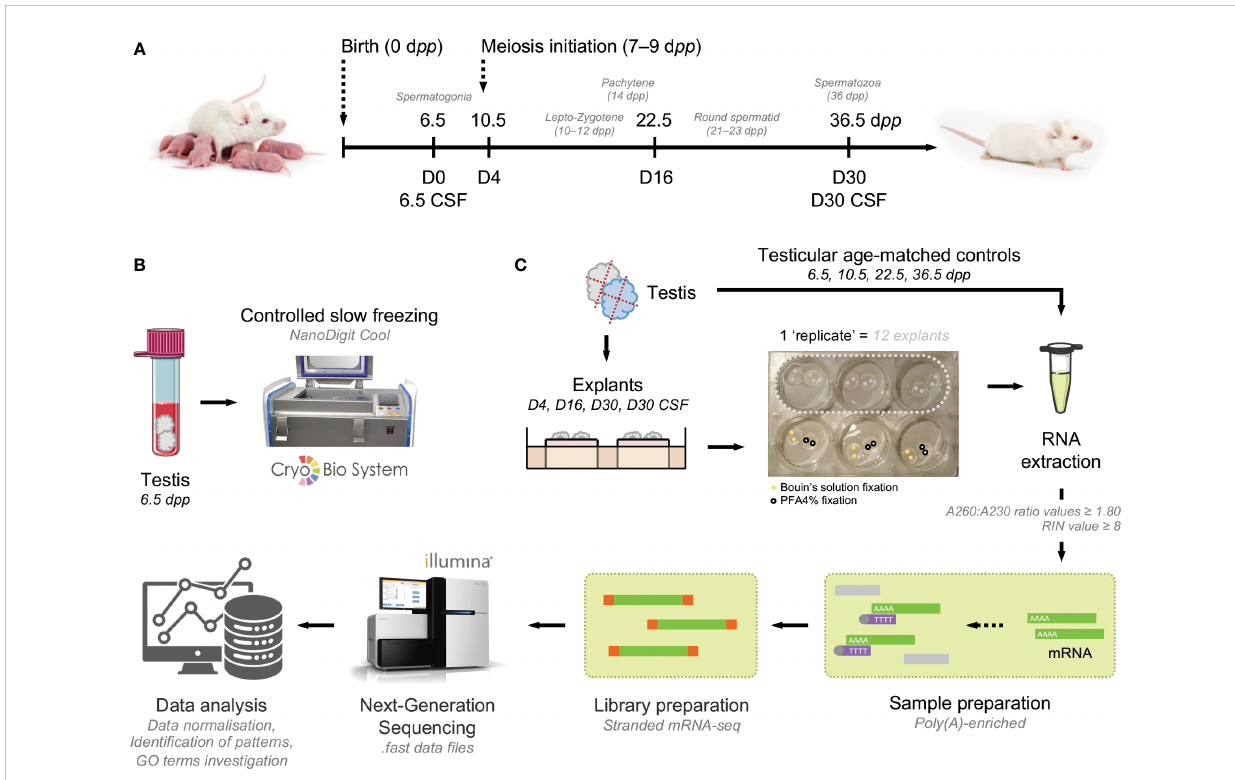
FIGURE 1 Flow chart of the study design. (A) Testicular fragments from 6.5 d pp mice were cultured from fresh or frozen-thawed testicular tissue with a medium composed of a -MEM, KSR, gentamycin, and Rol. These cultures were stopped at key time points of the fi rst spermatogenic wave: D4, D16, and D30 for fresh tissue in order to evaluate the impact of in vitro culture and stopped at D30 for frozen-thawed tissue in order to evaluate the impact of cryopreservation procedure. Testes from mice of 6.5, 10.5, 22.5, and 36.5 d pp correspond to respective age-matched in vivo controls. (B) Frozen 6.5 d pp testicular tissue were cryopreserved by a controlled slow freezing procedure. (C) Samples were cut into 4 fragments of 0.75 mm 3 and cultured onto a pair of agarose gels. Samples were fi xed in Bouin ’ s solution for histological analyses (n=3×6 fragments per condition) and PFA4% for STRA8 immuno fl uorescence (n=3×6 fragments per condition). Then, in order to perform transcript analysis, RNAs from testicular explants (n=3×6 fragments per condition) as well as their respective in vivo controls (n=3×6 fragments per condition) were extracted. Sample and